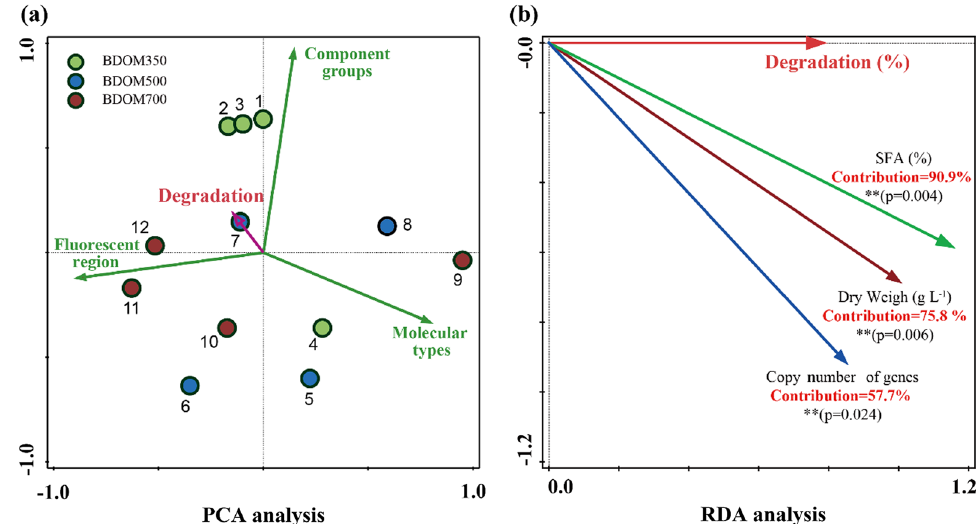
Fig. 3 PCA ( a ) and RDA ( b ) between the biodegradation of SMX and CAP and the characteristics of BDOM or